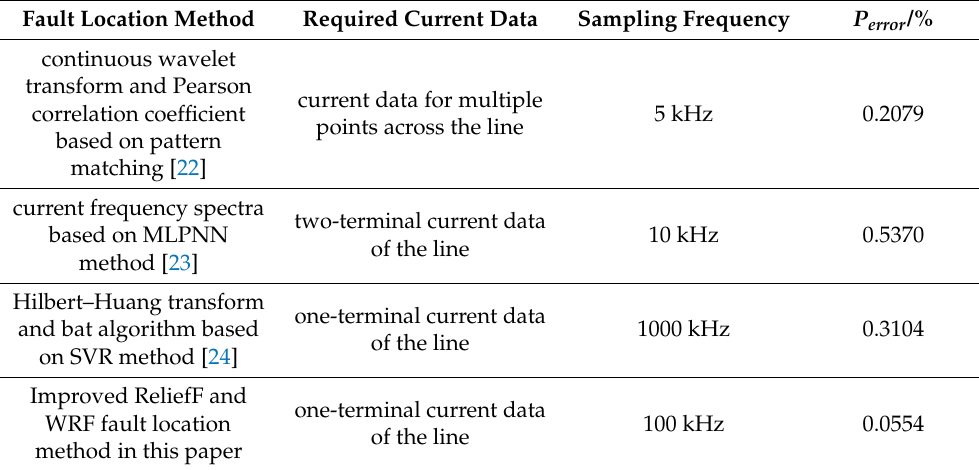
Table 7. Comparison with other intelligent fault location